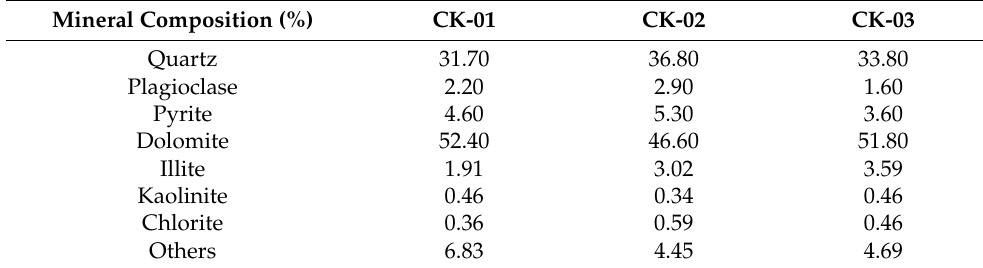
Figure 1. X-ray diffraction results (Q: quartz, D: dolomite, and P: pyrite). Table 1. Physical and chemical properties of the samples.